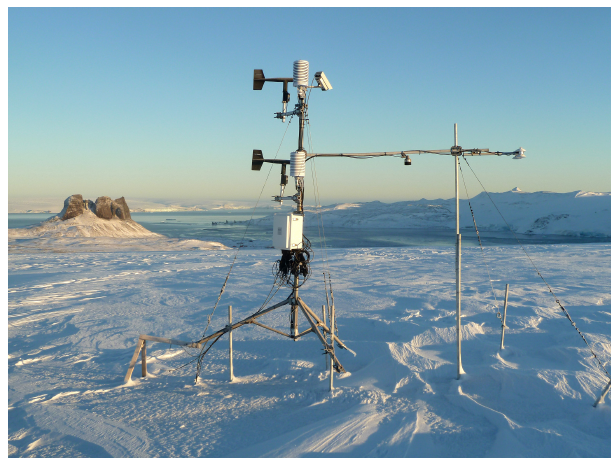
Figure 2. AWS installed on the Fourcade Glacier with view to the Potter Cove and Three Brothers Hill. The photo was taken during winter on 30 May 2012.